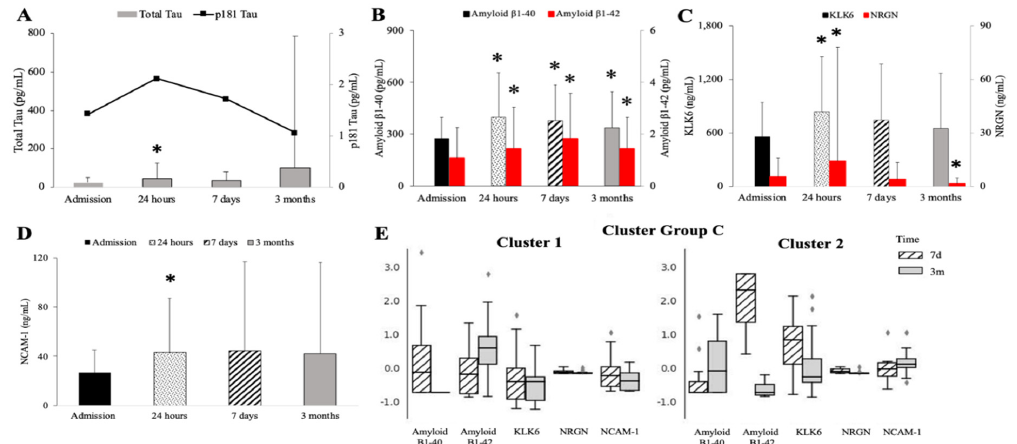
Figure 1. Time course of neurodegenerative markers after cardiac surgery. Levels of total τ au ( A , grey bars), p181tau ( A , line), amyloid β 1-40 ( B , black bars), amyloid β 1-42 ( B , red bars), KLK6 ( C , black bars), NRGN ( C , red bars), and NCAM-1 ( D ) at baseline, 24 h, 7 days, and 3 months. ( E ) Cluster analyses of Cluster 1 (XX patients) and Cluster 2 (XX patients) with levels of amyloid β 1-40 and β 1-42, KLK6, NRGN, and NCAM-1 at 7 days (striped bar) and 3 months (solid bar). * p < 0.05. ♦ signifies values outside the nominal range or